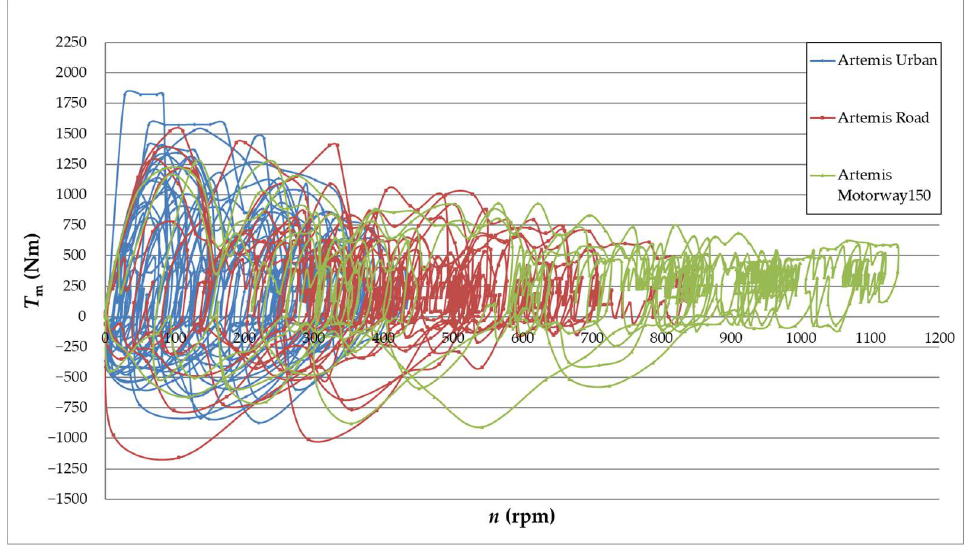
Figure 11. Curves showing the mixing of the motor operating point defined by torque and rotational speed during the Artemis Urban, Artemis Road, and Artemis Motorway150 driving cycle .